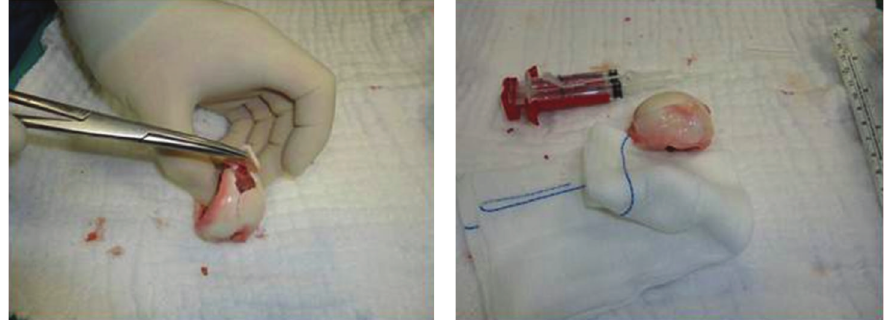
Figure 3: The chondral fragments sealed with fibrin glue before internal fixation.